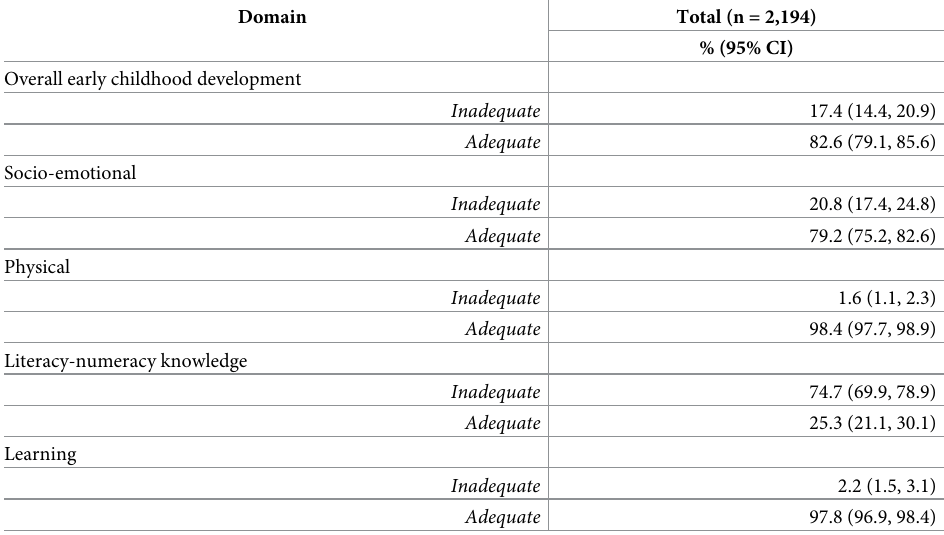
Table 2. Overall early childhood development and early childhood development by domain.